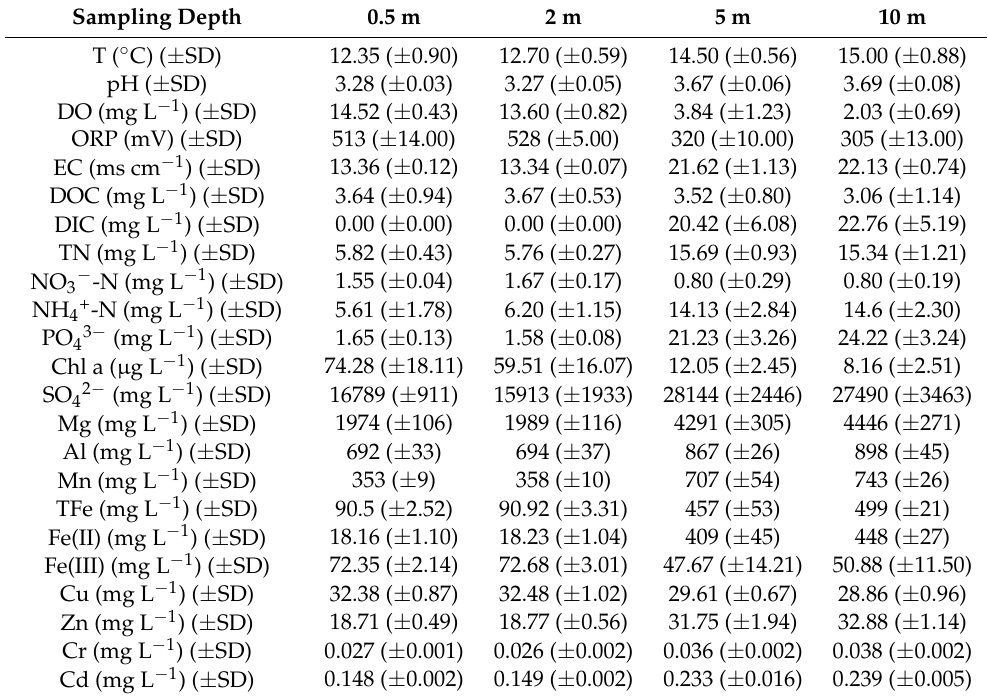
Table 1. Physicochemical parameters (mean ± SD) of AMD water at four depths in the pit